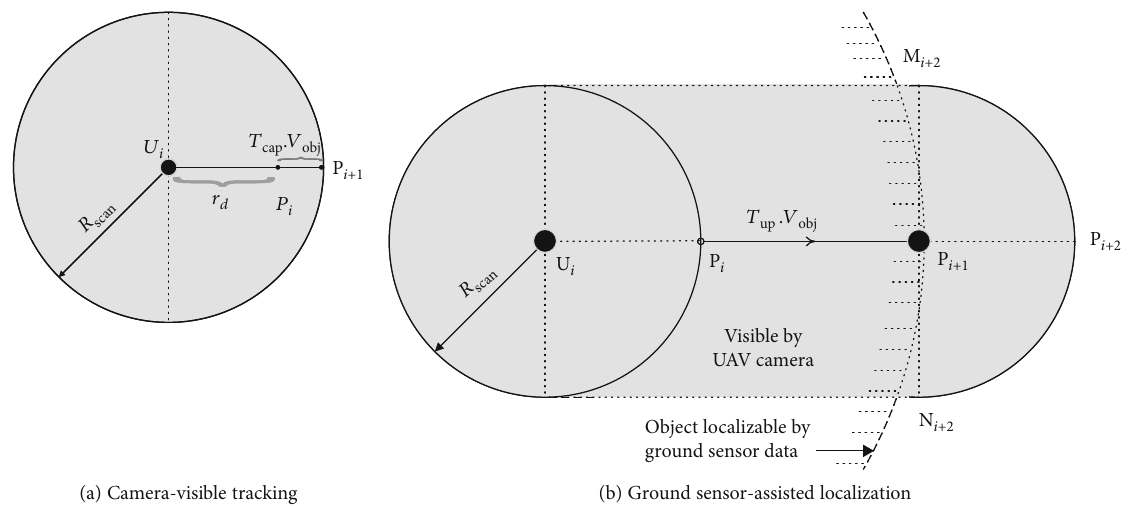
Figure 5: Camera-visible range (a) and ground sensor-localizable range (b) — they in fl uence assurance of tracking success.